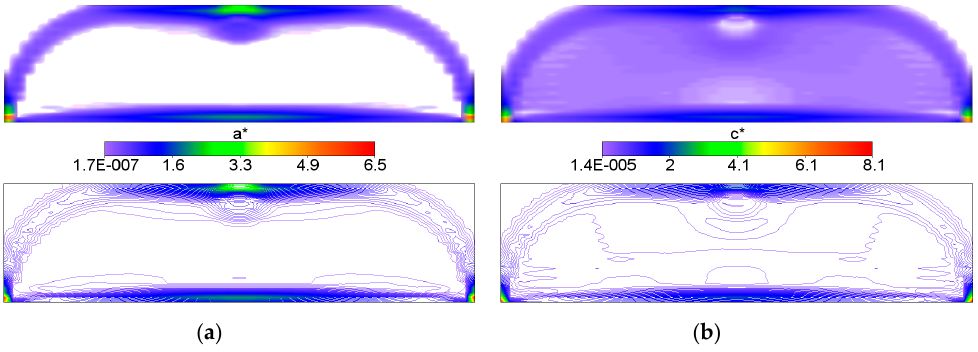
Figure 5. ( a ) Volume-render and ( b ) contours views of the optimal and relative (i.e., divided by E 0 ) layouts of a * and c * moduli, respectively.